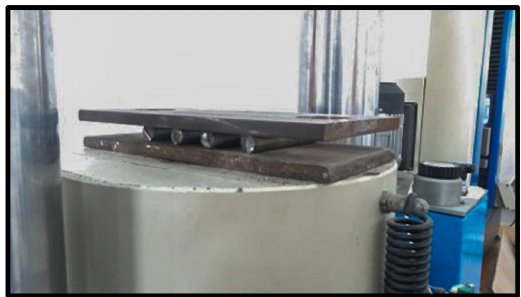
Figure 6. Set of steel plates and rollers for the direct shear test of push-off specimens